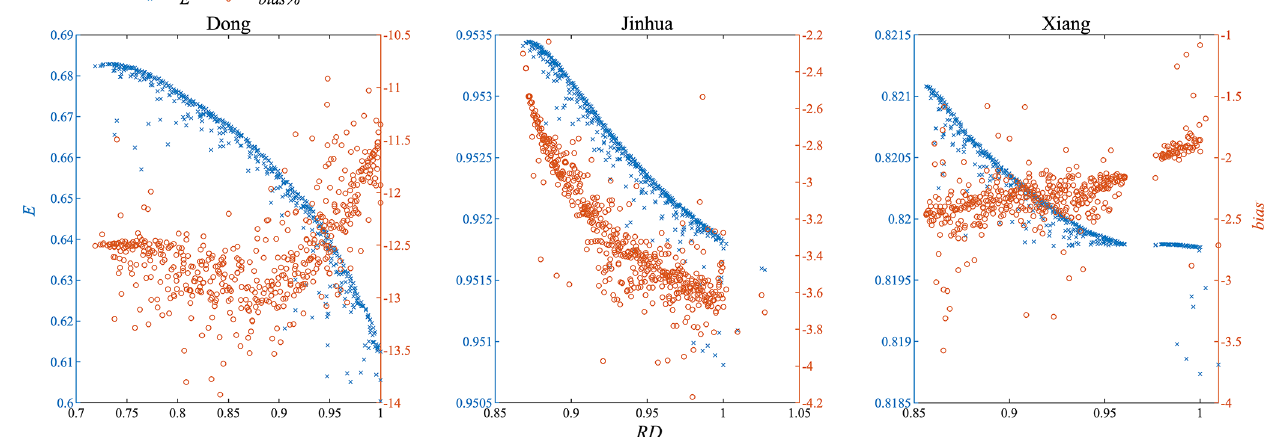
Figure 4. E –RD plots for the last generation from GA calibration.